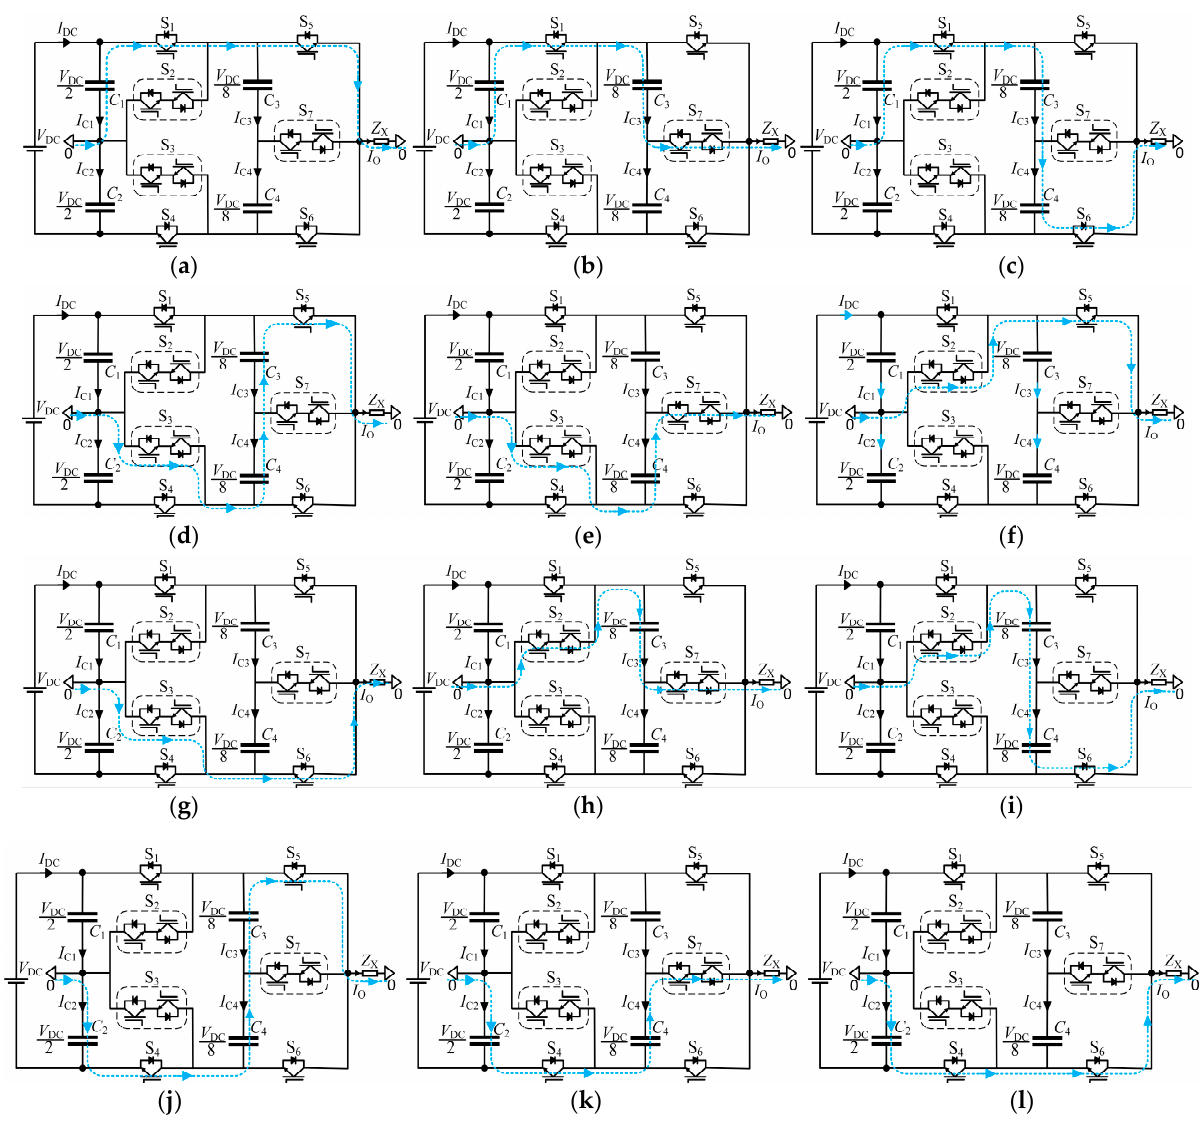
Figure 2. Operating states of the proposed 9-level topology. ( a ) V O = 4 E ; ( b ) V O = 3 E ; ( c ) V O = 2 E ; ( d ) V O = 2 E ; ( e ) V O = E ; ( f ) V O = 0; ( g ) V O = 0; ( h ) V O = − E ; ( i ) V O = − 2 E ; ( j ) V O = − 2 E ; ( k ) V O = − 3 E ; ( l ) V O = − 4 E.